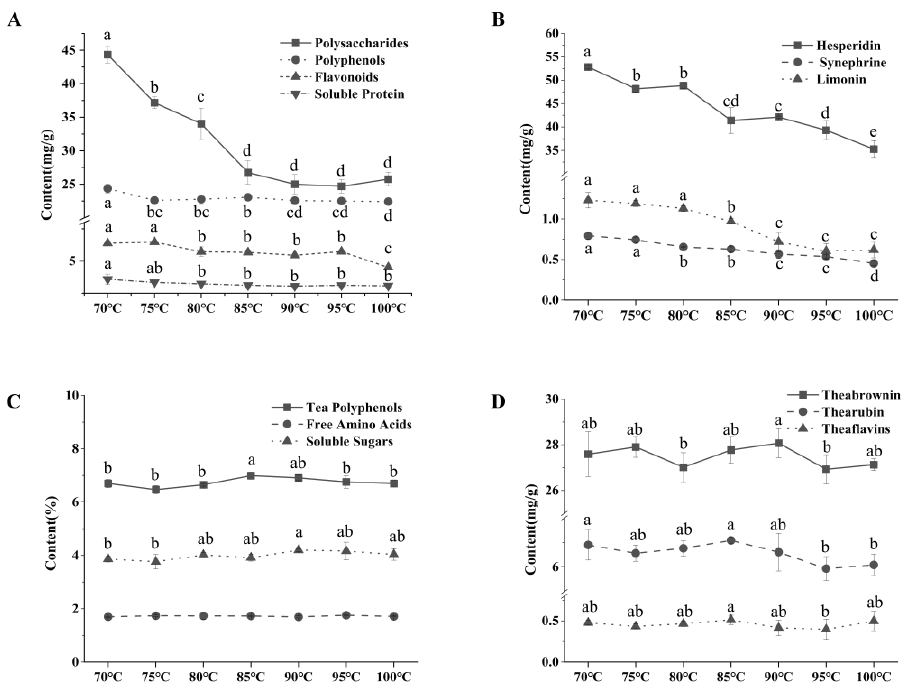
Figure 5. Physicochemical components of orange peel and tea at different fixed temperatures. ( A ) Main physicochemical components of orange peel. ( B ) Orange peel active substance. ( C ) The main physicochemical components of tea. ( D ) Tea pigments. (Different lowercase letters on the figure indicate significant difference at p < 0.05).